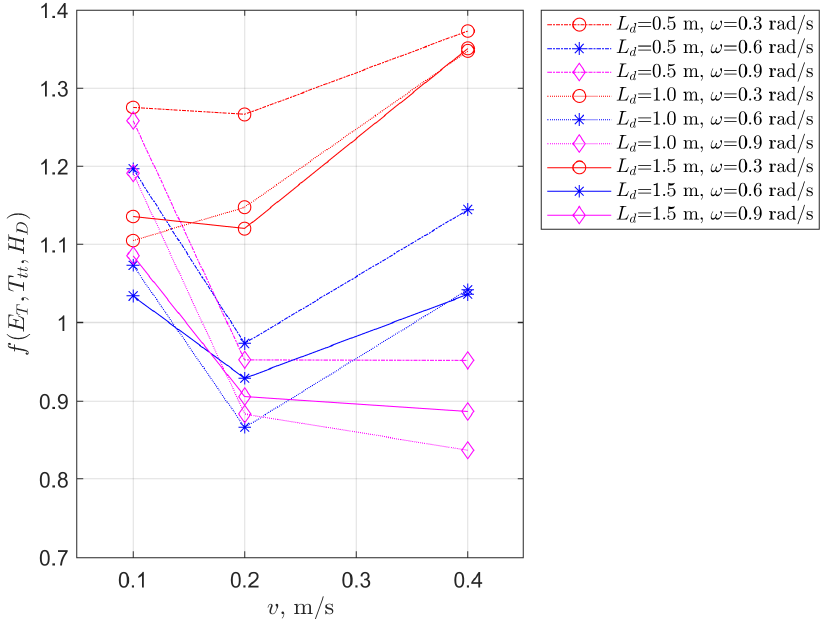
Figure 21. Cost function vs. linear speed for selected maximum values of the angular rate and look ahead distance—track